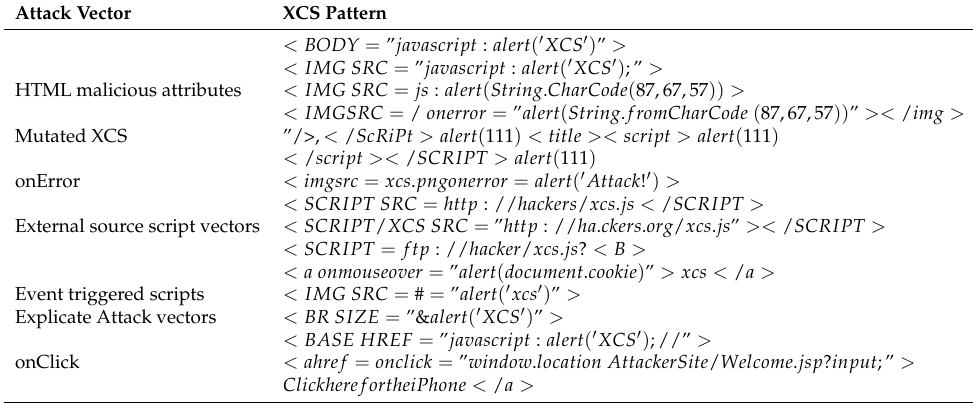
Table 3. XCS attack